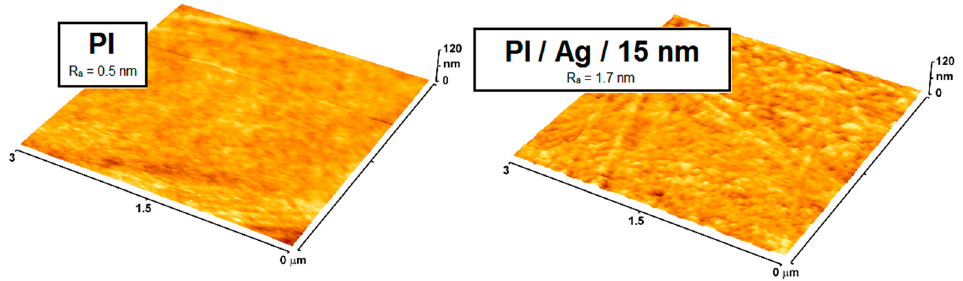
Figure 8. Atomic force microscopy (AFM) images of pristine polyimide (PI) and Ag nanolayer-coated PI, together with their surface roughnesses [48].